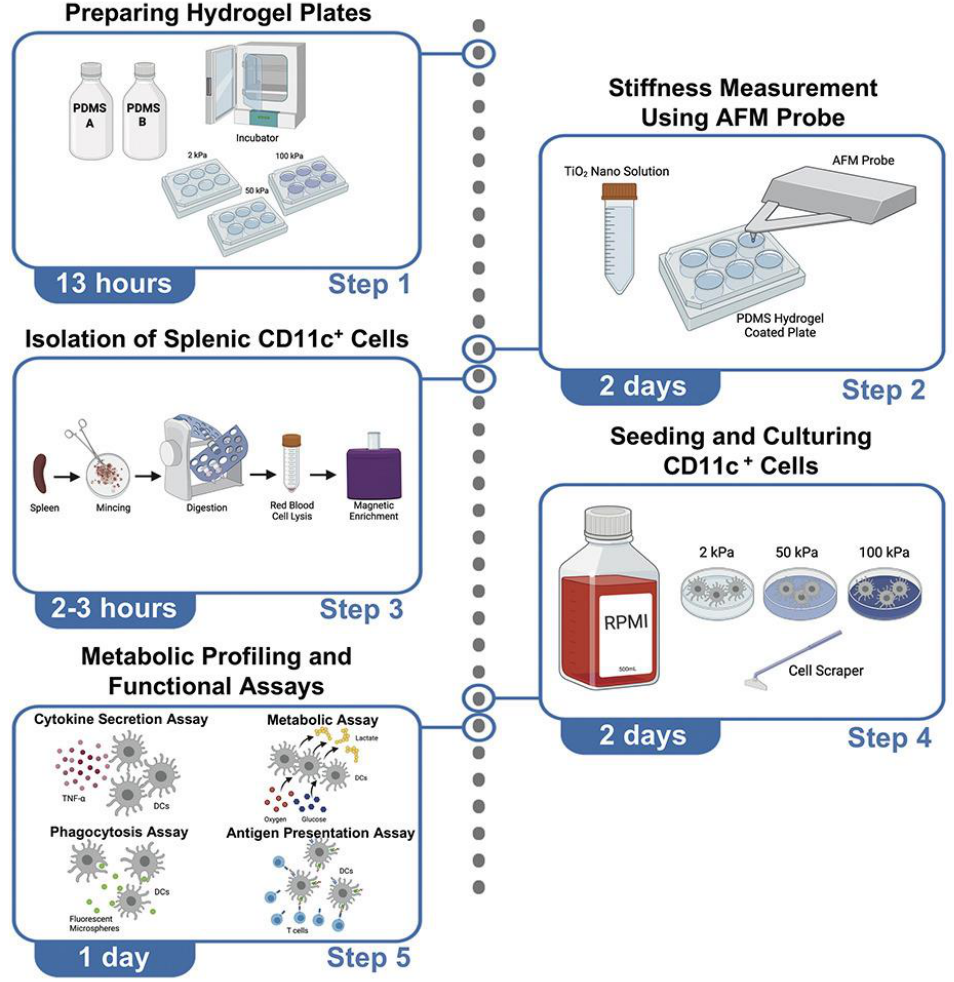
Figure 2. PDMS hydrogel-coated tissue culture plates with different substrate stiffnesses for exploring the impact on DC function (reprinted/adapted with permission from Ref. [30], 2022, Lee et al.).